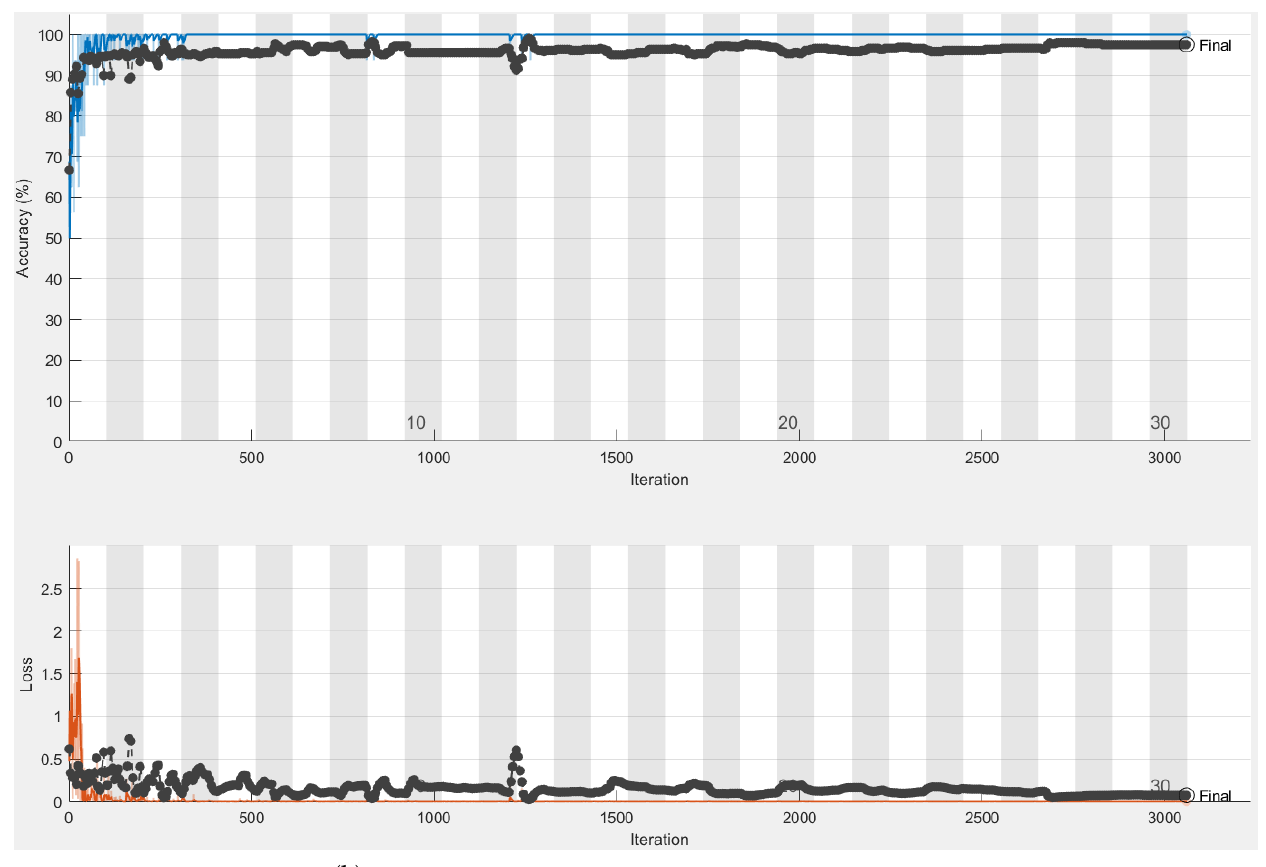
Figure 6. Training curve of the datasets analysed on Alexnet with Matlab. ( a ) Training curve of men at sea dataset; ( b ) training curve of paintings